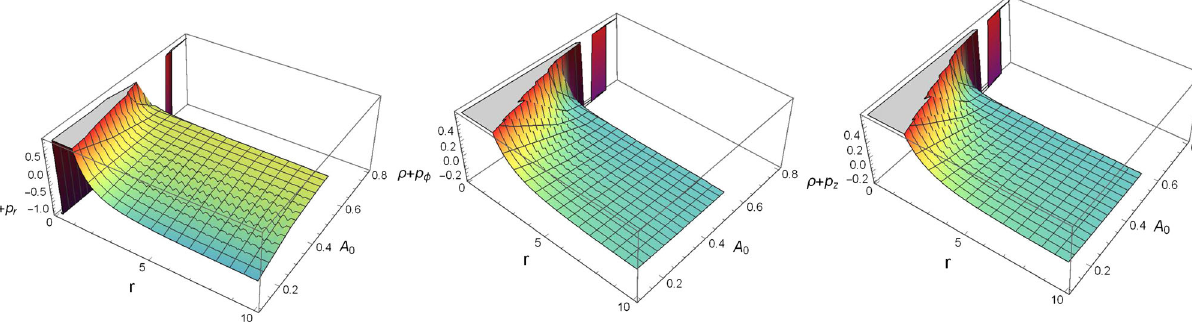
Fig. 2 Here, we shows variation of (ρ + p r ) (MeV/fm 3 ) , (ρ + p φ ) (MeV/fm 3 ) and (ρ + p z ) (MeV/fm 3 ) w.r.t r (km) with m = n = 1. CASE (A)